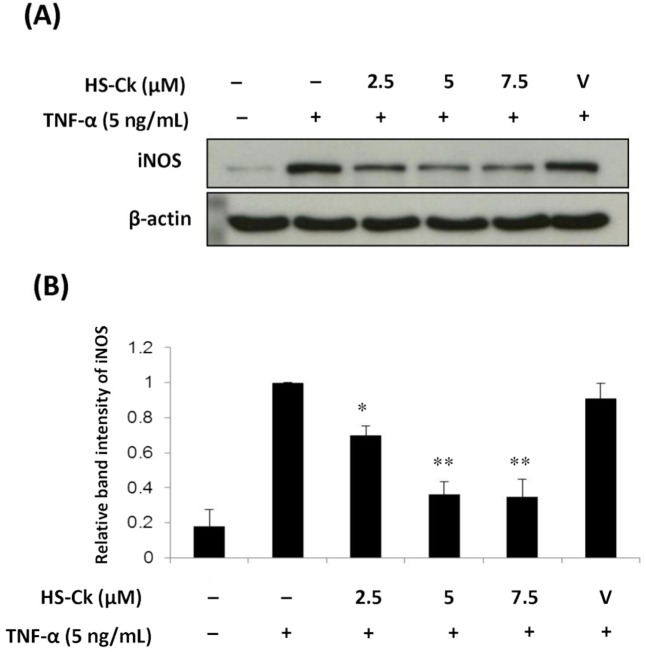
Effects of HS-Ck on the expression levels of iNOS in TNF-α-induced porcine chondrocytes.(A) Porcine chondrocytes were pretreated with various doses of HS-Ck or the DMSO solvent as vehicle (V) control for 2 h and then stimulated with TNF-α for 24 h. The expression levels of iNOS and β-actin were determined by using Western Blotting assay. (B) The relative band intensity of iNOS was normalized as the corresponding the band of β-actin. The representative data out of at least three independent experiments are shown. *P < 0.05 and **P < 0.01 compared to the TNF-α-stimulated in the absence of HS-Ck treatment.